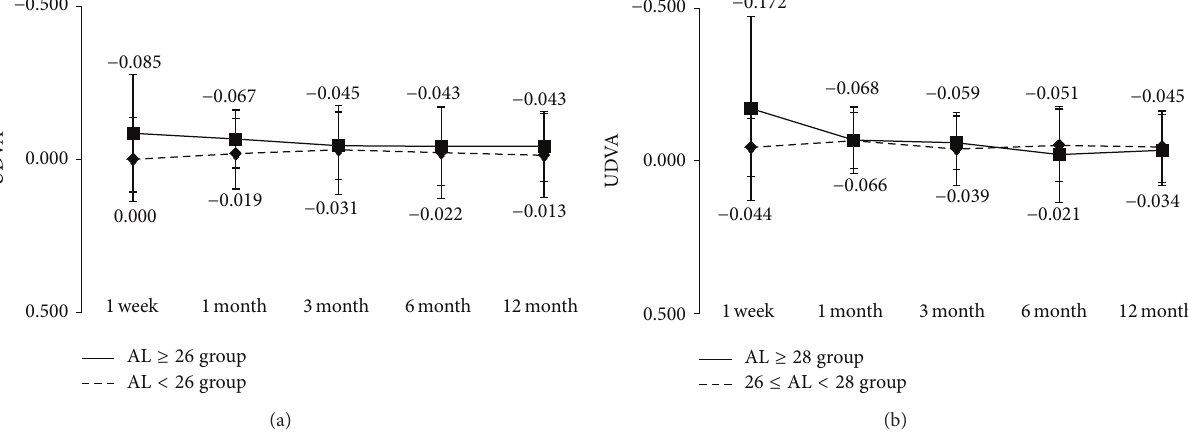
Figure 1: Uncorrected distance visual acuity during 12-month follow-up after implantation of multifocal intraocular lens. (a) Eyes were divided into axial length of 26mm or longer (AL ≥ 26 group) and less than 26mm (AL < 26 group). (b) Eyes in AL ≥ 26 group were further divided into 26 ≤ AL < 28 group and AL ≥ 28 group. ∗ NS Mann-Whitney 𝑈 test.